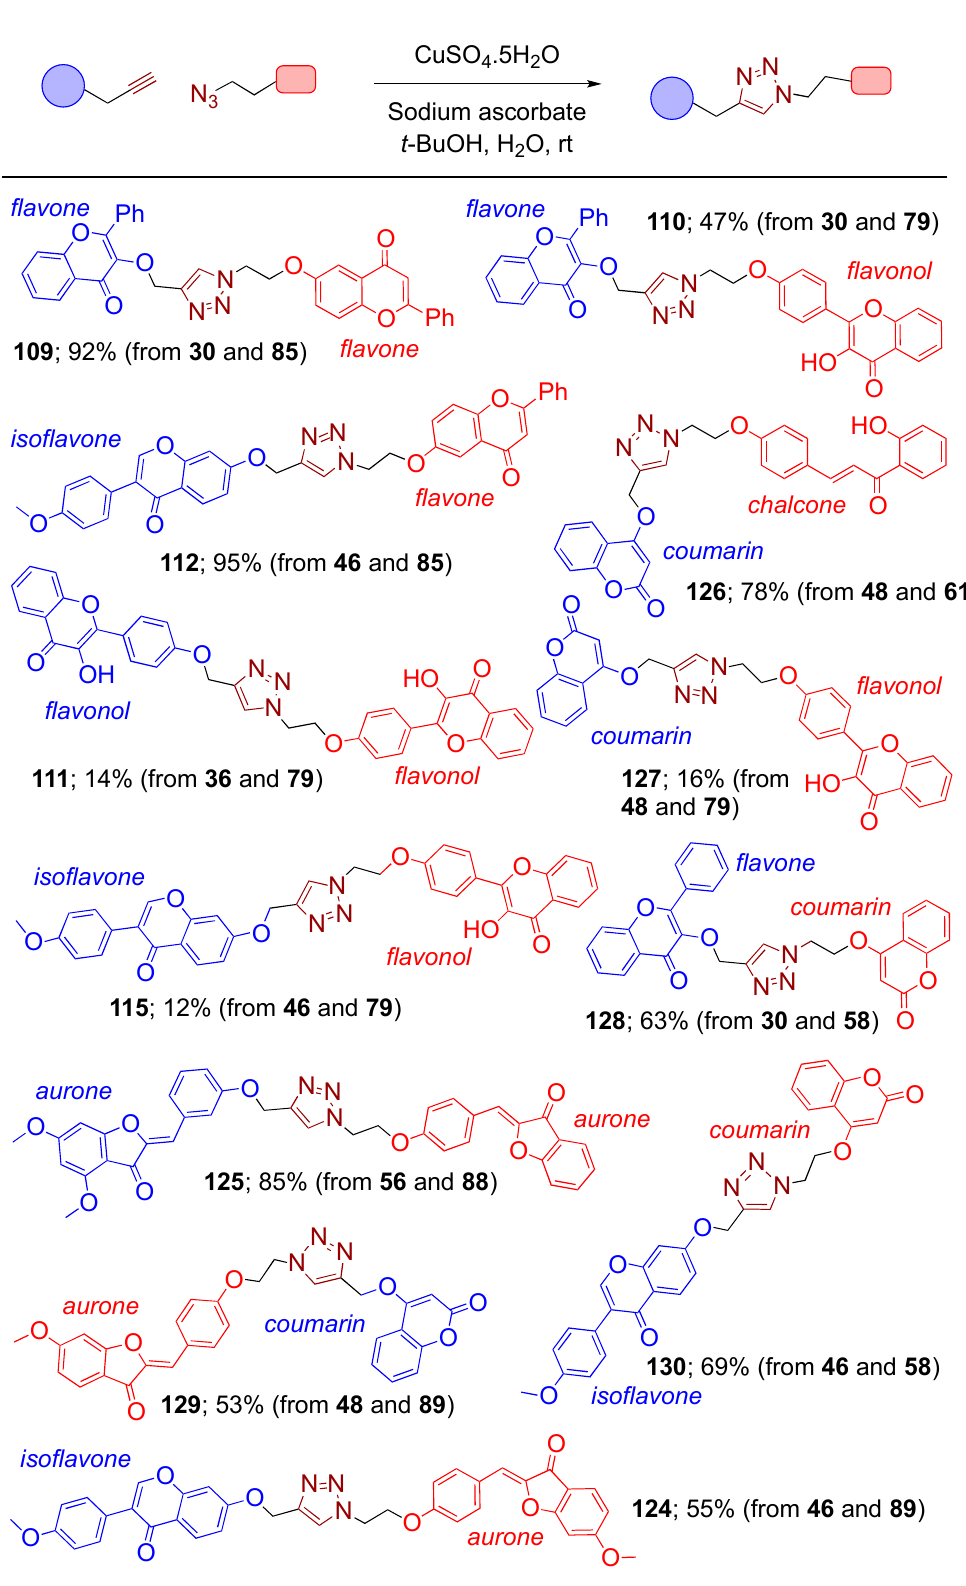
Scheme 19. Synthesis of some triazole-bridged dimers.